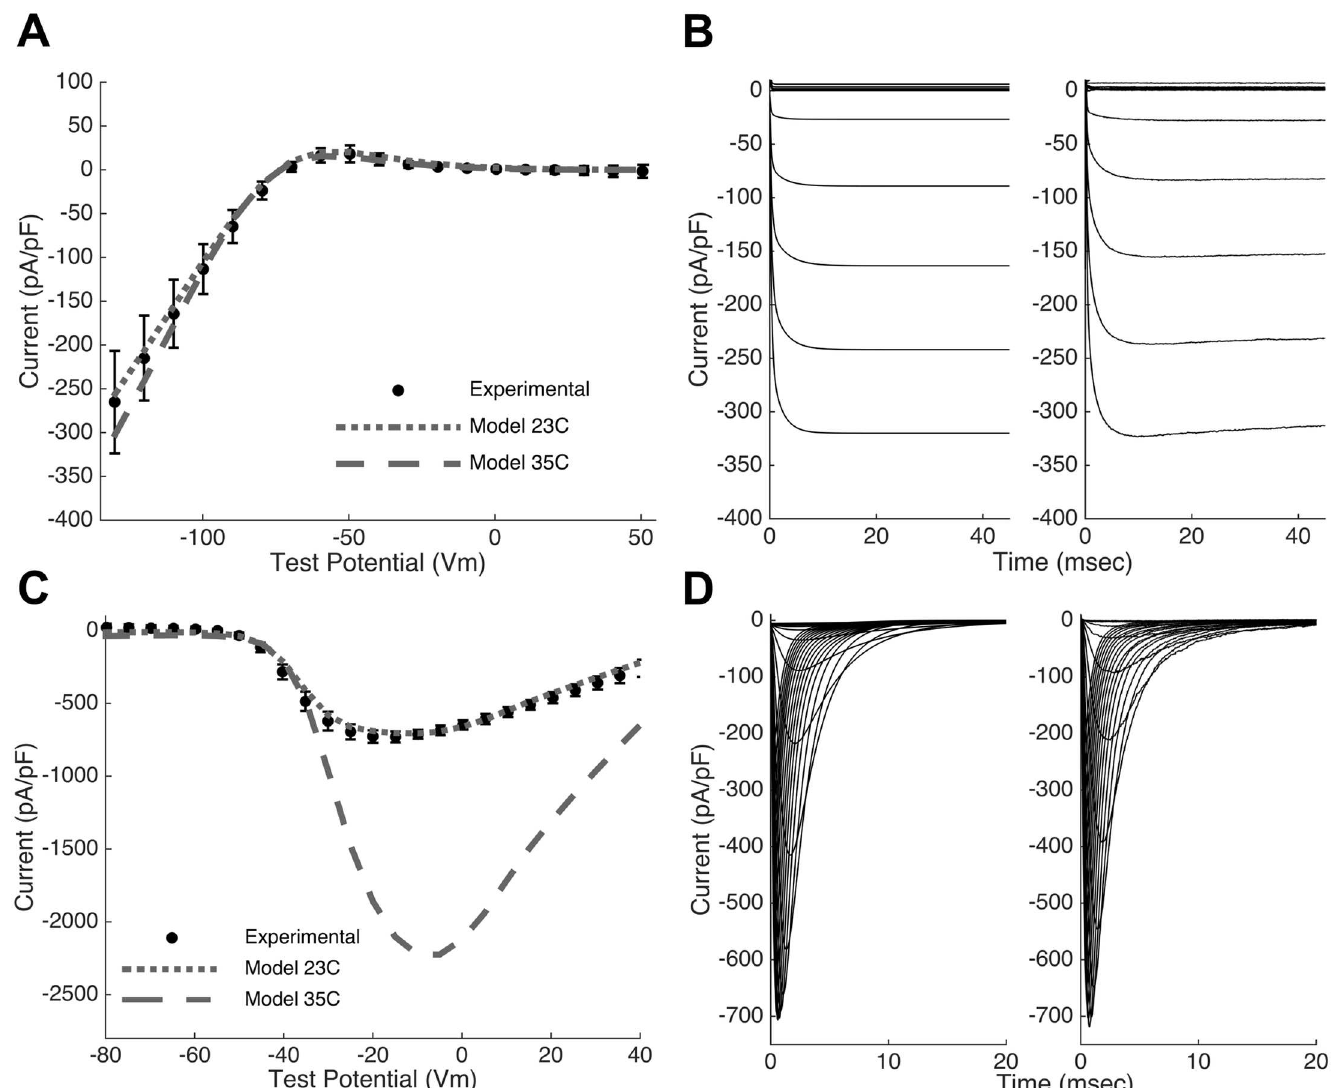
Fig 1. Model recapitulates experimental current properties. (A,C) The Ex293 membranemodel replicates (dotted line) the experimentally observed peak current-voltage relationships (closedcircles) of the transfected potassium and sodium channels at 23˚C. An increasein current density and shift in voltagedependence is seen in the model at physiological temperature (dashedline) (B,D) The model (left panel)also replicates the dynamics of channel activity (right panel). Note that the model conductances in panelsB and D were selected to match the experimental traces; these are not the same as the mean model